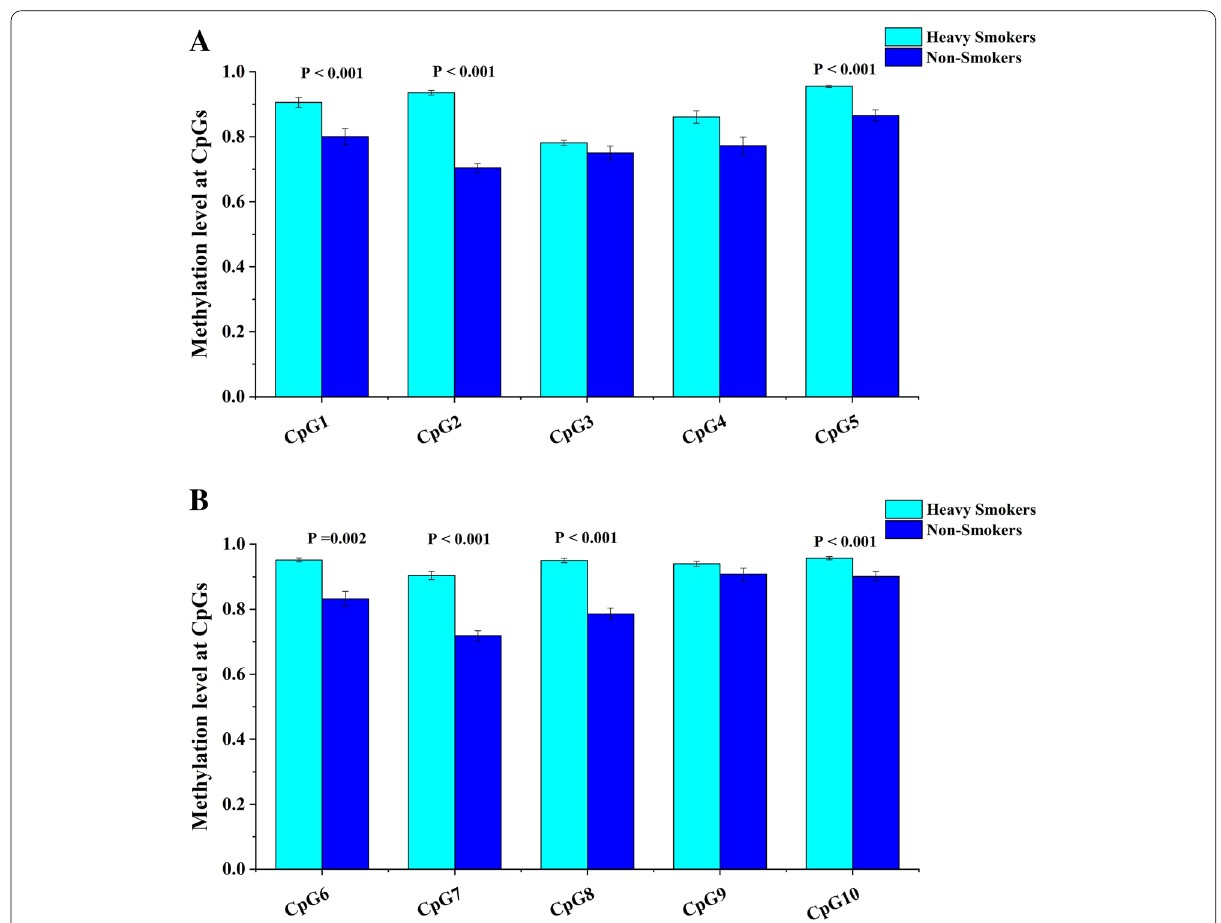
Fig. 4 A , B Methylation level at CpGs within GAA gene-related amplicon in heavy smokers compared to non-smokers. P < 0.05: significant; P not significant